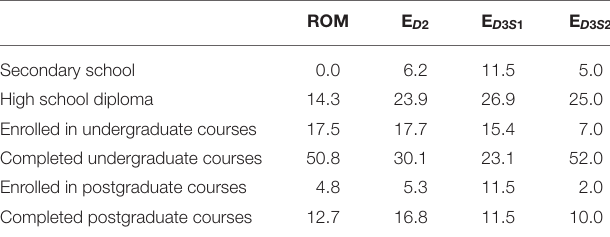
TABLE A3 | Percentage of participants with a certain level of education.